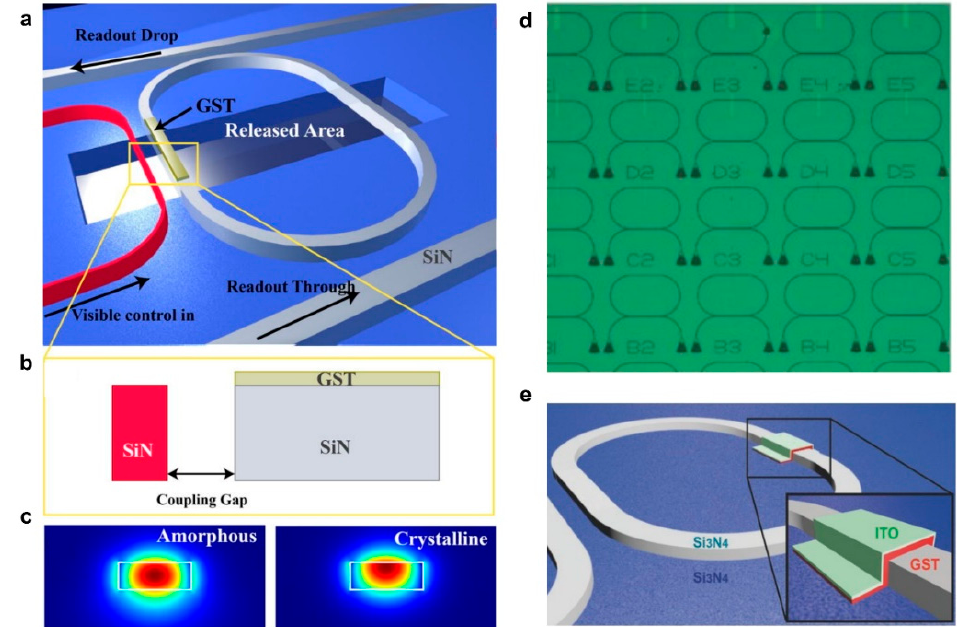
Figure 7. Phase change materials for integrated photonics computing. ( a – c ) Schematic overview of the proposed memory element [63]. ( d ) Optical microscopy image of an array with 25 different memory elements [64]. ( e ) Three-dimensional scheme of the platform using partially etched ridge waveguides in silicon [64]. ( a – c ) Reprinted with permission from Ref. [63], AIP Publishing. ( d , e ) Reprinted with permission from Ref. [64]. © 2013 WILEY-VCH Verlag GmbH & Co. KGaA, Weinheim.